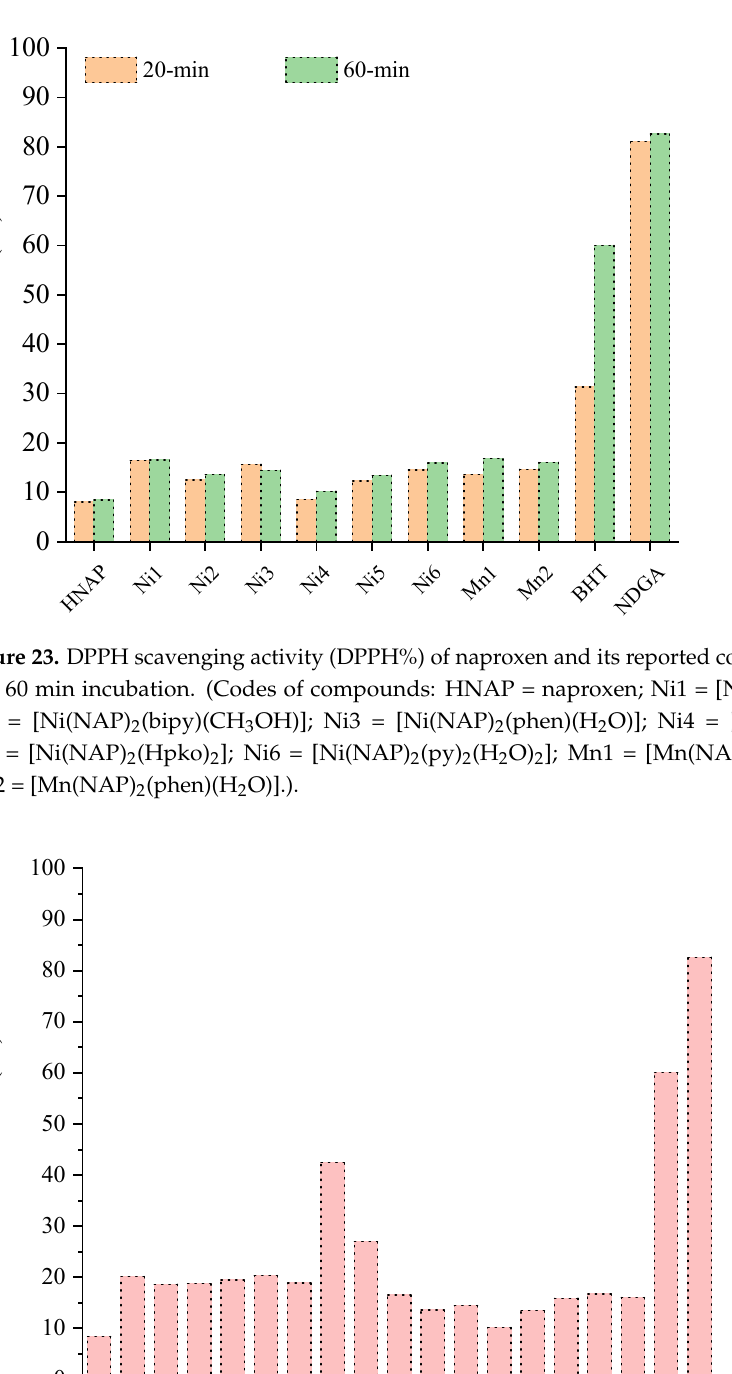
Figure 24. DPPH radicals’ scavenging activity (DPPH%) of naproxen and its reported complexes after 60 min treatment. (Codes of compounds: HNAP = naproxen; Cu1 = [Cu 2 (NAP) 4 (H 2 O) 2 ]; Cu2 = [Cu(NAP) 2 (py) 2 (H 2 O)]; Cu3 = [Cu(NAP) 2 (phen)] · H 2 O; Cu4 = [Cu(NAP) 2 (bipy)] · H 2 O; Co1 = [Co(NAP) 2 (CH 3 OH) 4 ]; Co2 = [Co(NAP) 2 (py) 2 (H 2 O) 2 ]; Co3 = [Co(NAP) 2 (phen)(H 2 O) 2 ]; Co4 = [Co(NAP) 2 (bipy)(H 2 O) 2 ]; Ni1 = [Ni(NAP) 2 (CH 3 OH) 4 ]; Ni2 = [Ni(NAP) 2 (bipy)(CH 3 OH)]; Ni3 = [Ni(NAP) 2 (phen)(H 2 O)]; Ni4 = [Ni(NAP) 2 (bipyam)]; Ni5 = [Ni(NAP) 2 (Hpko) 2 ]; Ni6 = [Ni(NAP) 2 (py) 2 (H 2 O) 2 ]; Mn1 = [Mn(NAP) 2 (py) 2 (H 2 O) 2 ] and Mn2 = [Mn(NAP) 2 (phen)(H 2 O)].).